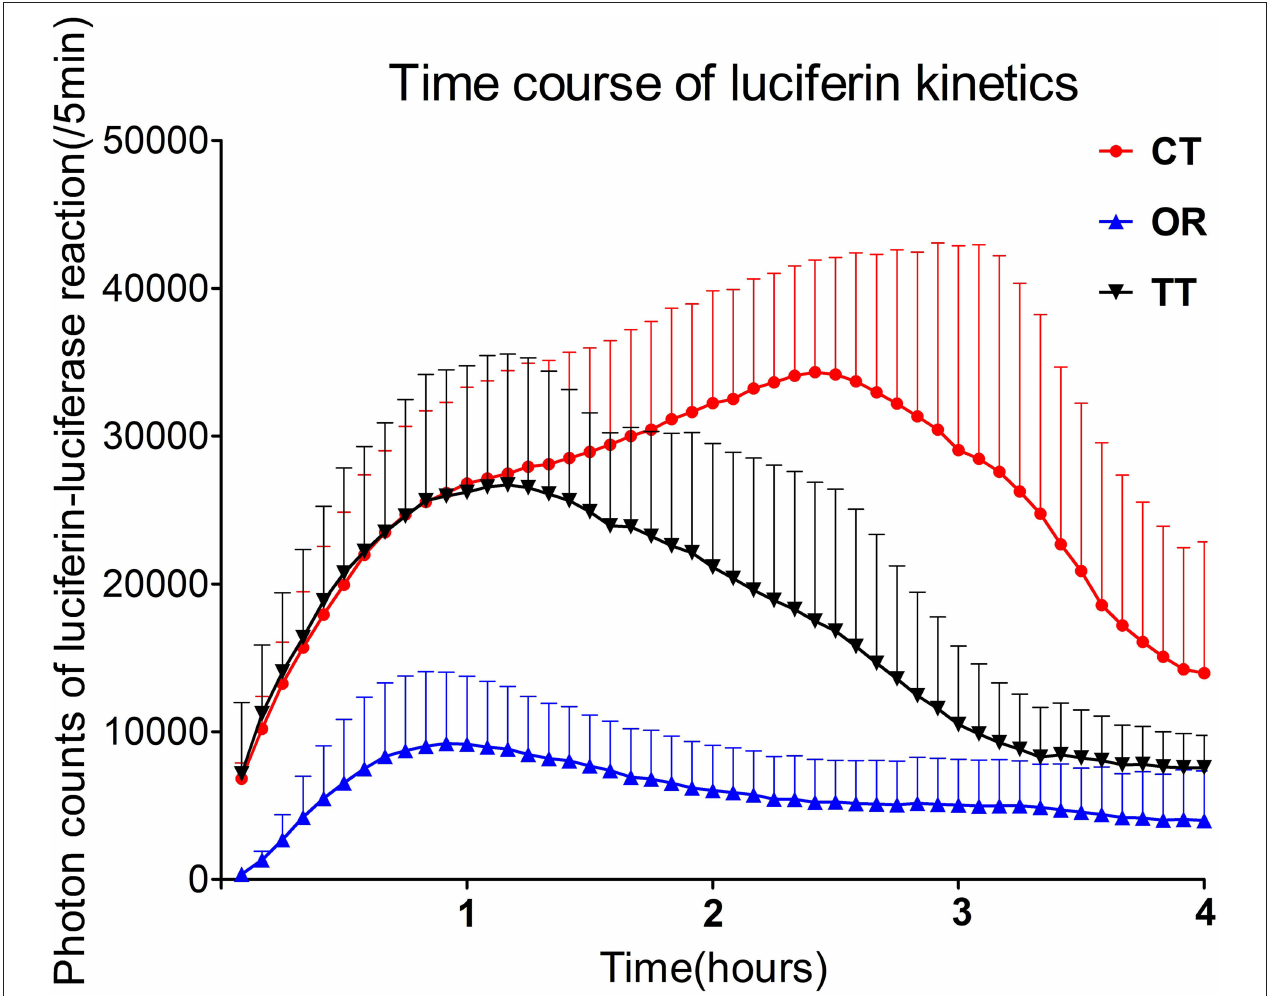
FIGURE 2 | Time-dependent changes in photon counts of GFAP-Luc mice administered luciferin via different routes. Error bars indicate standard errors.